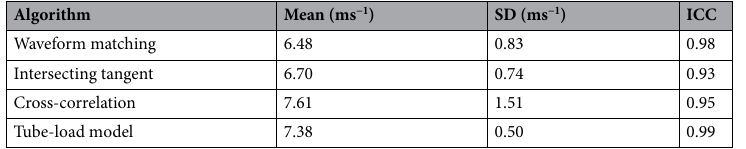
Table 4. The repeatability analysis for the four algorithms using the experimentally measured carotid and femoral pulse waveforms.